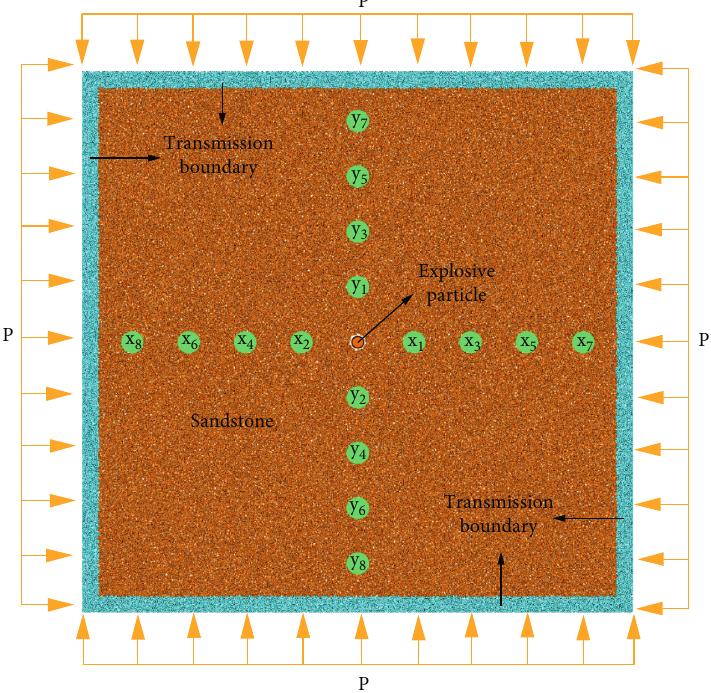
Figure 4: Schematic diagram of single-hole blasting